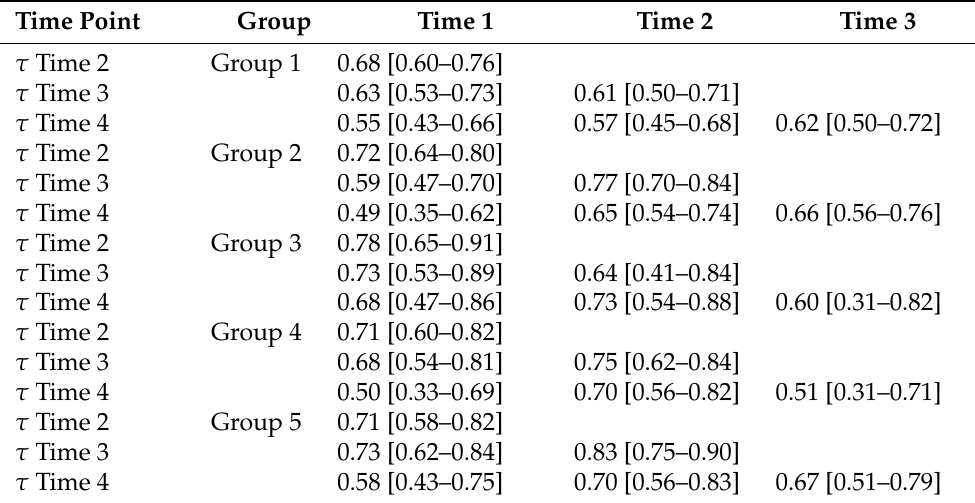
Table A9. Correlation matrix of non-decision times across four time points split by groups.